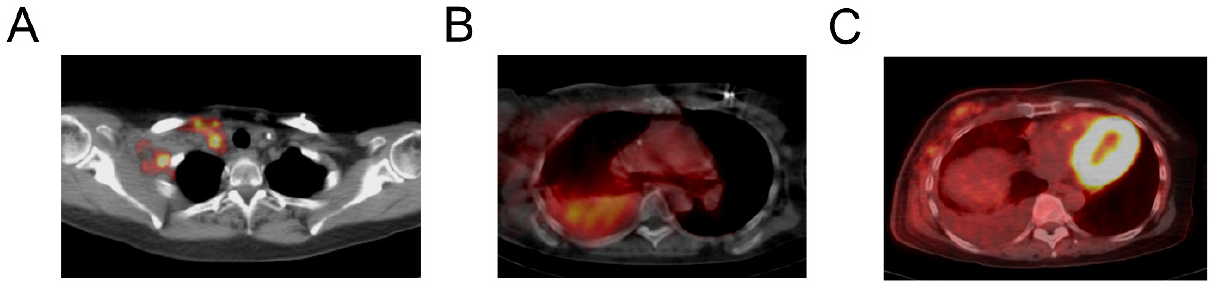
Figure 5. A 53-year-old woman with metastatic triple-negative breast cancer imaged with both [ 124 I]I-CLR1404 and [ 131 I]I-CLR1404. Fused PET/CT image ( A ) obtained 6 days after 124 I-CLR1404 administration shows abnormal uptake within the right axillary and cervical region, corresponding to metastatic involvement of the body wall and lymph nodes. Fused SPECT/CT image ( B ) obtained 21 days after injection of [ 131 I]I-CLR1404 shows increased activity within a moderate-sized right pleural effusion, which was proven malignant by cytology after thoracentesis. Increased pleural uptake was also seen on [ 124 I]I-CLR1404 PET (not shown) but not on [ 18 F]FDG PET ( C ). Note also prominent myocardial uptake with FDG, which is generally not seen with